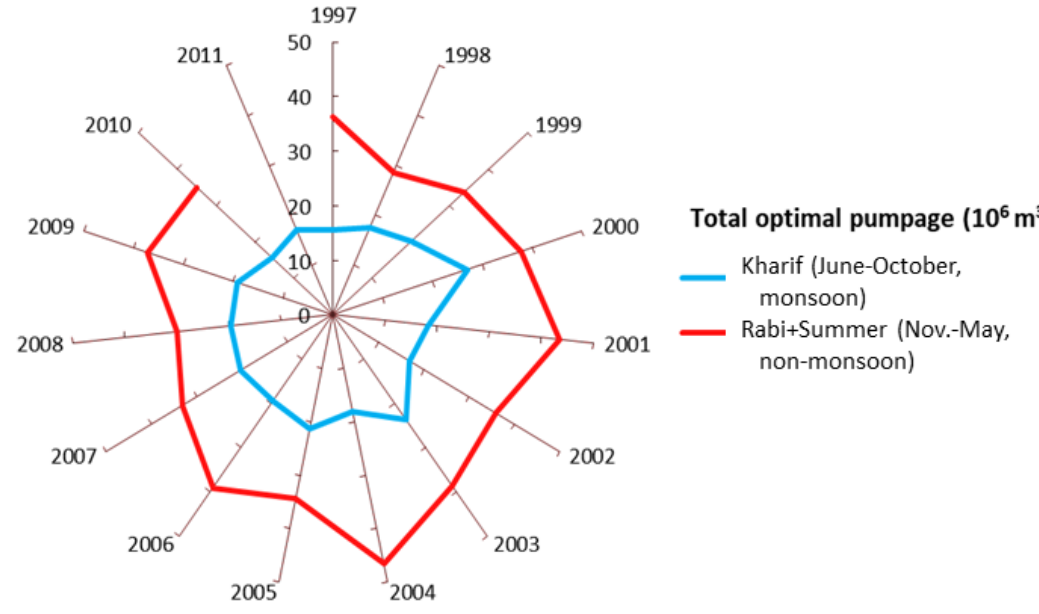
Figure 7. Seasonal total optimal groundwater withdrawals for 1997 to 2011, computed by S-OGM.